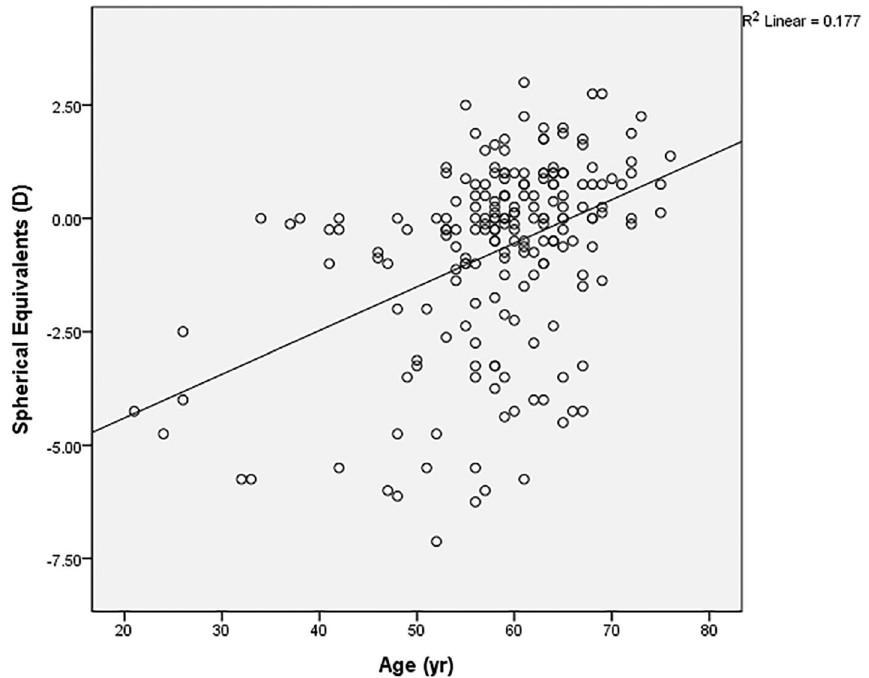
Figure 1. X-axis presents the age when the first vitreous floater symptom occurred, while Y-axis presents the spherical equivalent value in diopters (D). The oblique line of best fit is showing a positive correlation between the spherical equivalent value and age. (r = 0.421, p < 0.001 in the Pearson’s correlation analysis).